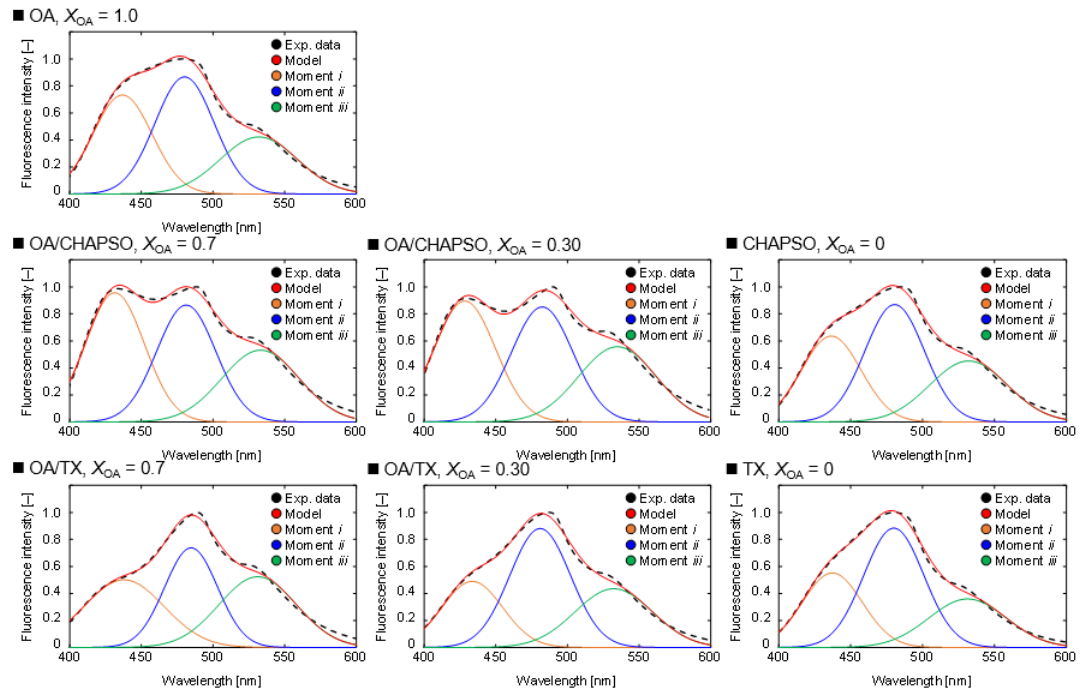
Figure 5. Deconvolution results of Laurdan spectra by the measurement of a 20 mM OA vesicle ( X OA = 1.0), 20 mM OA/detergent bicelles ( X OA = 0.30 and 0.70) and detergent solutions ( X OA = 0) at 298 K. The experimental data (black) are fitted by the model (red), which consisted of moment i (orange), moment ii (blue), and moment iii (green), respectively.